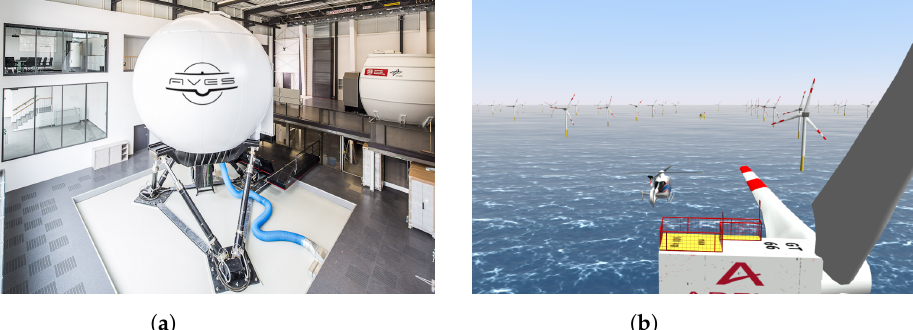
Figure 12. AVES simulation facility at DLR. ( a ) AVES research simulator. ( b ) Maritime offshore scenario of Global Tech I (GTI).